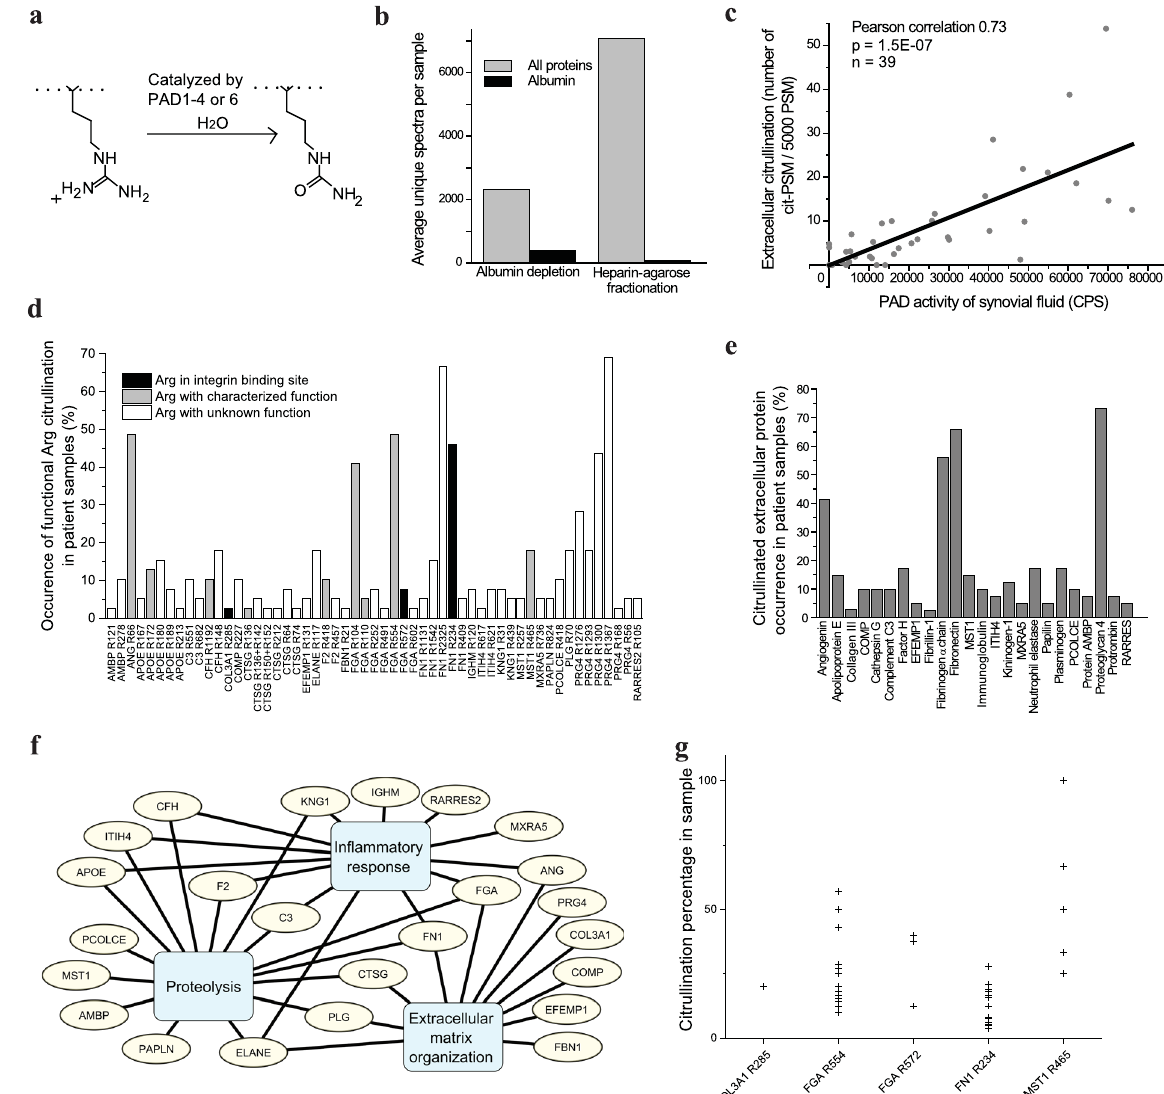
Figure 1. The analysis of citrullination in human synovial fluid samples. ( a ) Illustration of protein citrullination by PAD enzyme. ( b ) Number of detected unique spectra by mass spectrometry in albumin depleted or heparin fractionated synovial fluid samples (n = 11). ( c ) Correlation of extracellular citrullination (mass spectrometry, MS) and PAD activity (enzyme assay). ( d ) Detected citrullinated sites of extracellular proteins in synovial fluid samples. ( e ) The citrullinated extracellular proteins identified in synovial fluids (n = 40). The frequency (%) of samples containing the given citrullinated protein is shown. ( f ) The relationships of the extracellular citrullinated proteins to selected biological processes according to the GO Database 6/2014 release 45 appended with current knowledge of the biological role of angiogenin 46–48 , MXRA5 49 , PRG4 50 and EFEMP1 51 . IGHM, which is a subunit of IgM is connected to inflammatory response. ( g ) Citrullination levels of the arginines with a characterized function in individual samples. Only the arginines present in both citrullinated and non- citrullinated peptides were